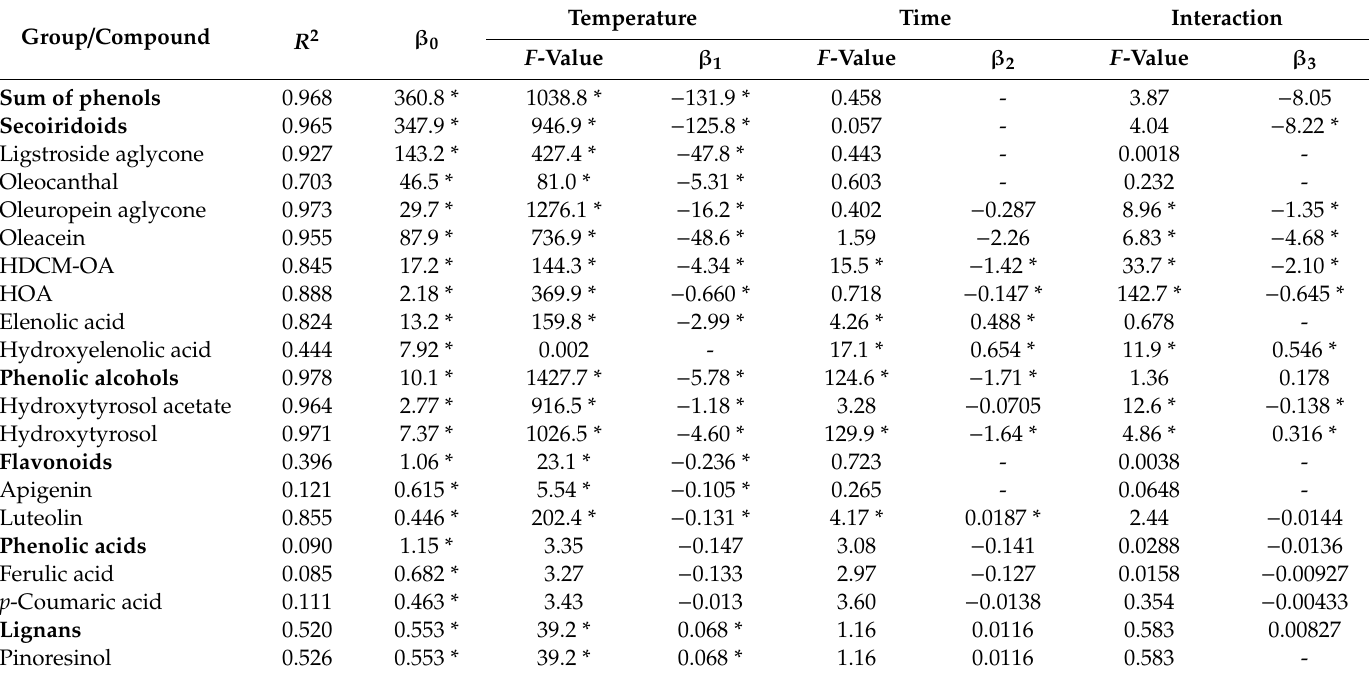
Table 3. Statistical results of the ANOVA and the lineal